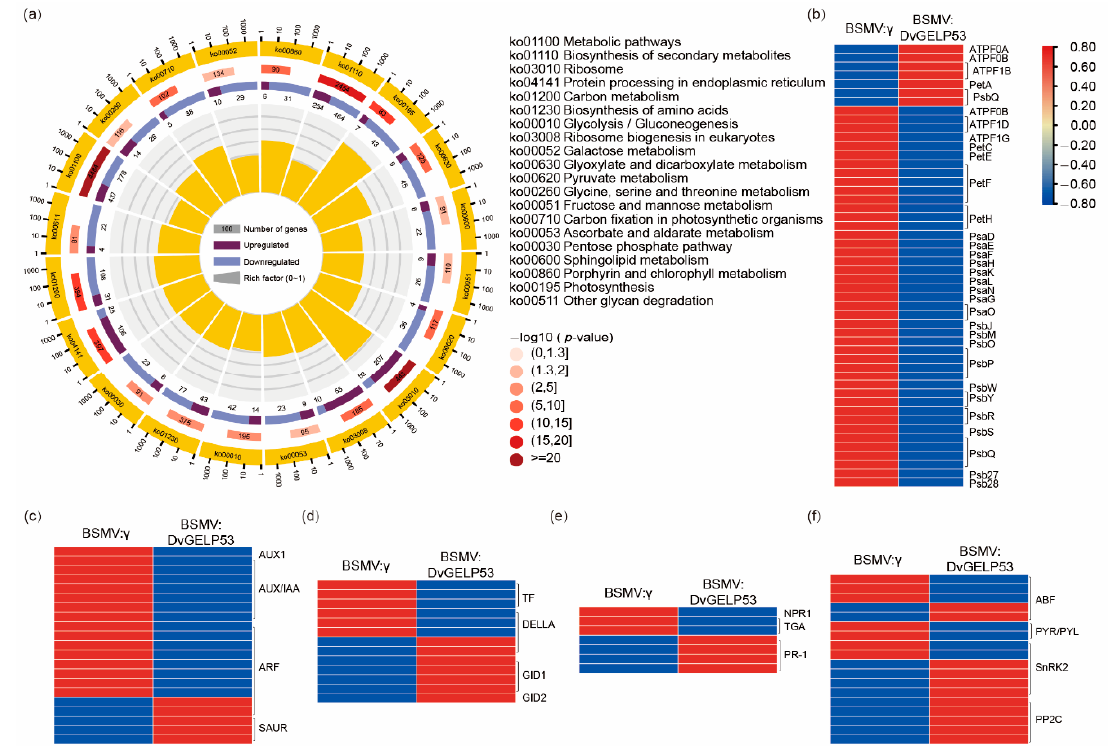
Figure 8. Transcriptome analysis of BSMV: γ and BSMV:DvGELP53. ( a ) KEGG pathway analysis of BSMV: γ and BSMV:DvGELP53 for the third leaves inoculated with virus. The circular chart represents distinct KEGG pathways of differentially expressed genes (DEGs). The graph is divided into four circles from the outside to the inside. The first circle represents the terms of enrichment and the outside of the circle is the coordinate ruler of the number of genes. The second circle represents the number of background genes in the category and the p -value. The length of the bar represents the number of genes and the shade of red represents the size of the p -value. The third circle represents the ratio of the number of upregulated and downregulated genes, dark purple and light purple represent upregulated and downregulated genes, respectively, and the number of genes is shown below. The fourth circle represents the rich factor value of each category, and each box in the background represents 0.1. Heatmap of photosynthesis ( b ), IAA ( c ), GA ( d ), SA ( e ) and ABA ( f ) pathway DEGs in case of BSMV: γ and BSMV:DvGELP53. The expression signal of each gene is based on the Z-score normalization